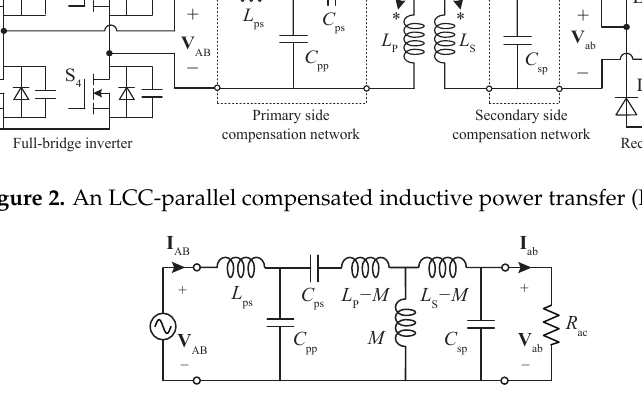
Figure 3. The LCC-parallel resonant tank